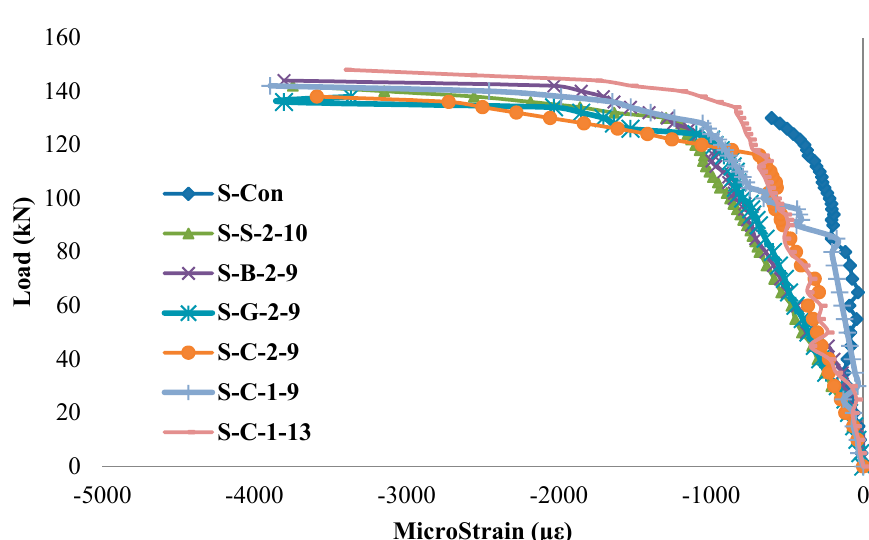
Figure 12. Applied load vs. maximum compressive strain of concrete slabs.